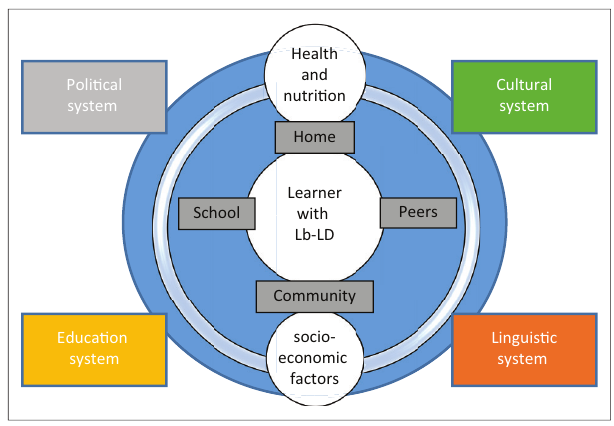
FIGURE 1: The system of language-based learning